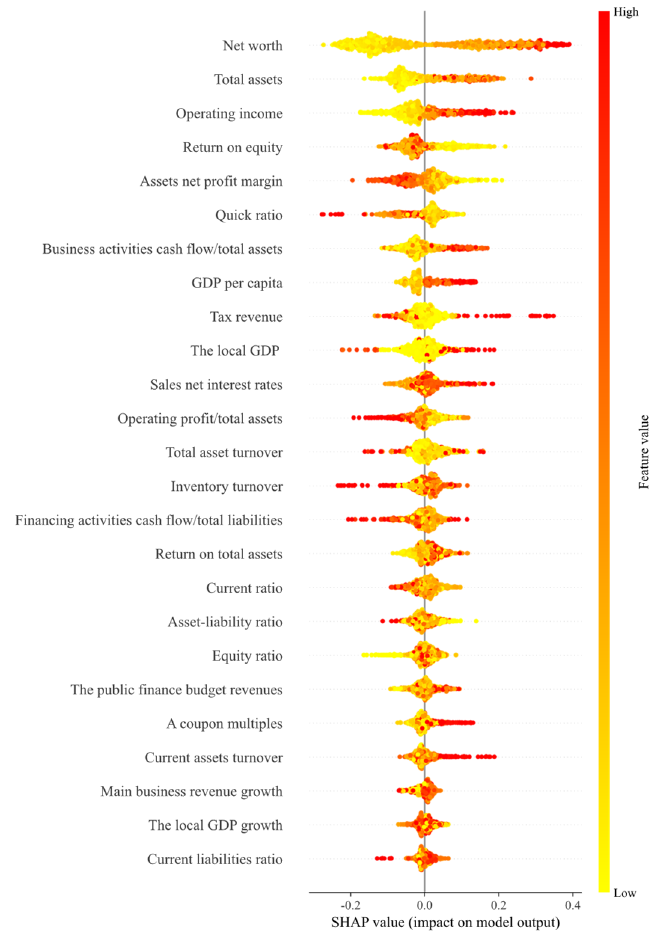
Figure 8. Analysis of influence degree of characteristic variables.